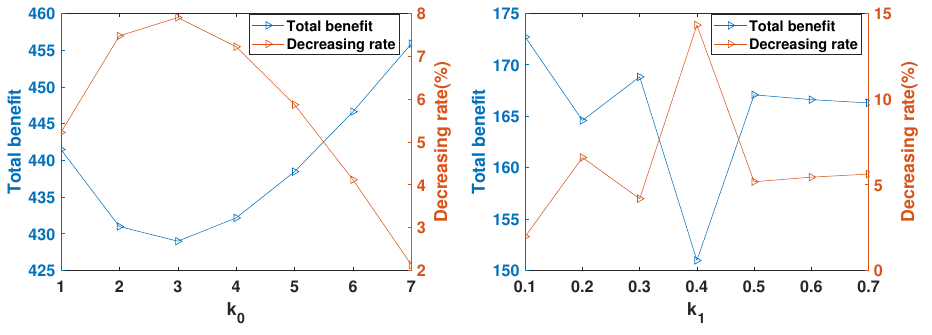
Figure 6. The impact of changes in k 0 and k 1 for a single role on the model. Table 6. The impact of changes in k 0 and K 1 for a single role on the